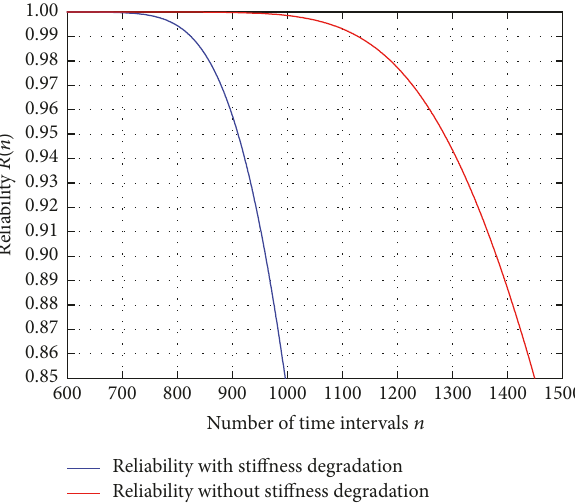
Figure 4: Reliability from proposed models and reliability from Monte Carlo simulations.